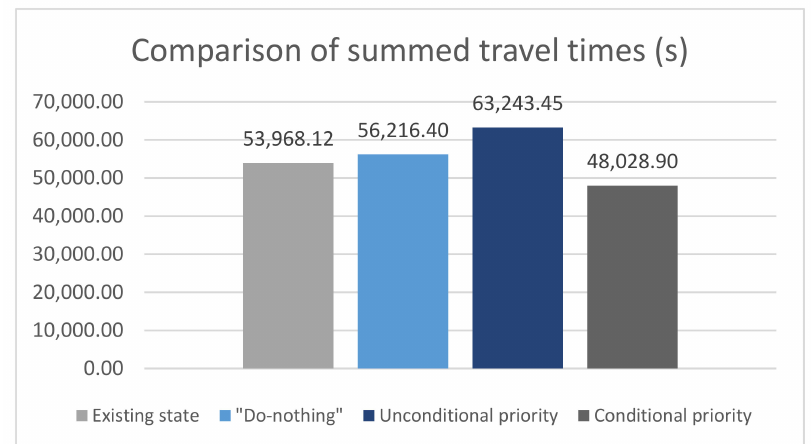
Figure 10. Comparison of summed travel time of all tram lines (s) in morning and afternoon peak